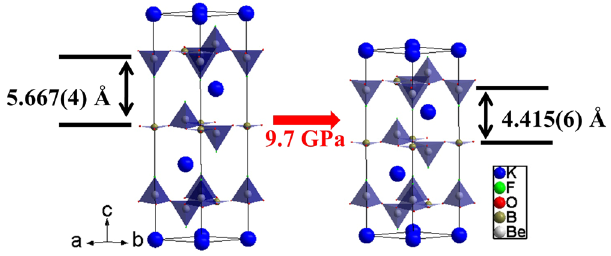
Figure 4. Structural schematics showing the large compression (more than 20%) along the c axis from AP to 9.7 GPa for